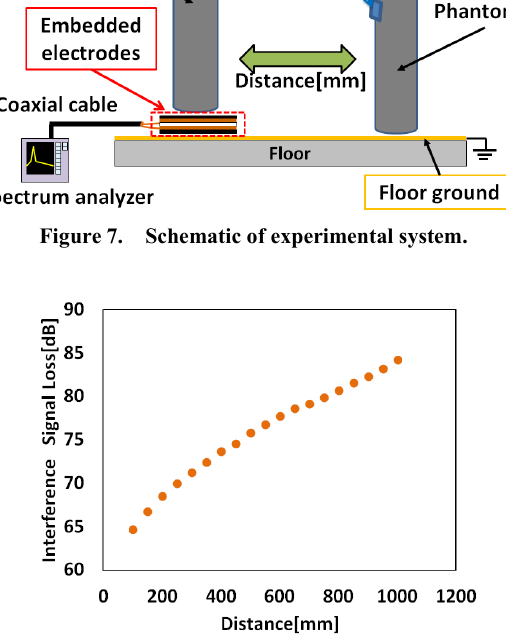
Figure 8. Interference signal loss according to distance between phantom 1 and 2 in